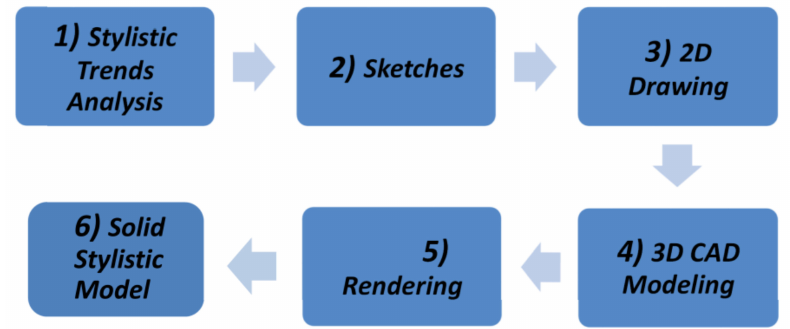
Figure 11. Summary diagram of SDE